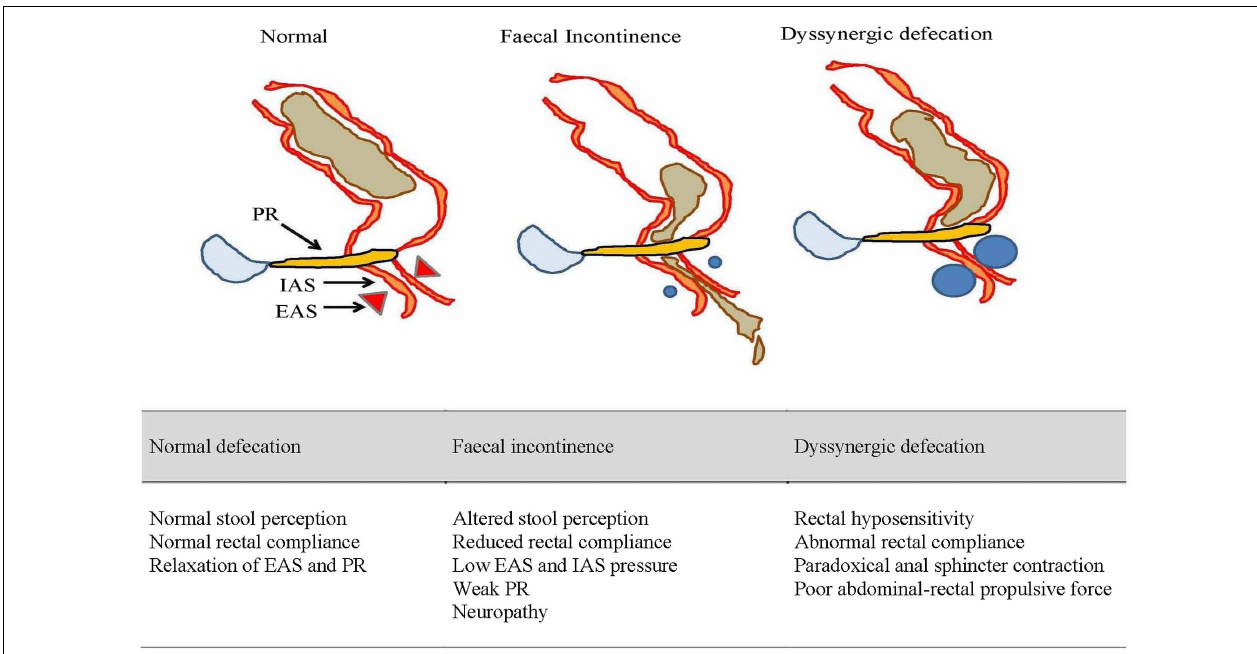
FIGURE 2 |An illustrated summary of normal defecation and physiological disruptions that underlie fecal incontinence and dyssynergic defecation. EAS, external anal sphincter; IAS, internal anal sphincter; PR, puborectalis